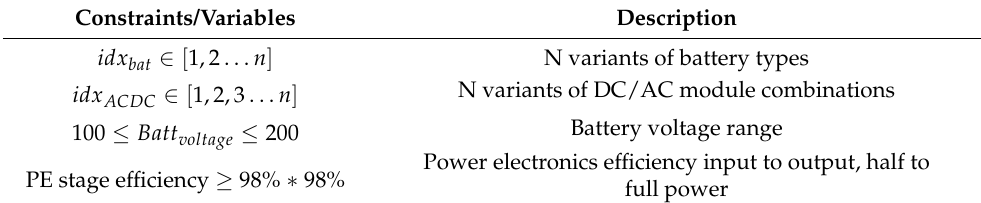
Table 3. Specifications and constraints for PCS-